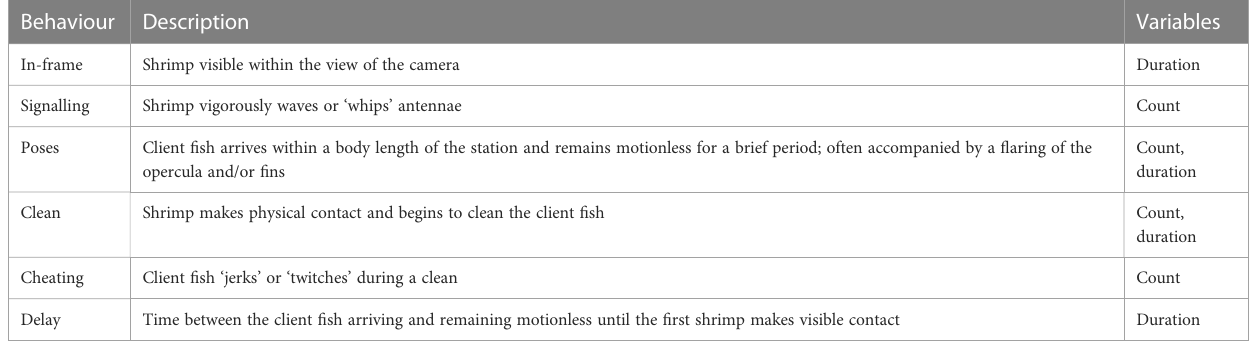
TABLE 2 Ethogram for the recorded interspeci fi c behaviours by Ancylomenes pedersoni and client fi shes. Behaviour